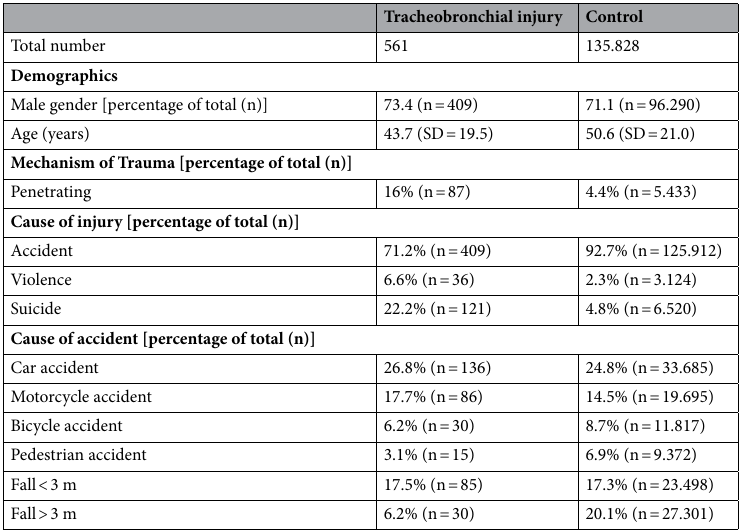
Table 1. Demographics and trauma mechanisms of all patients, and of all suffering tracheobronchial trauma.